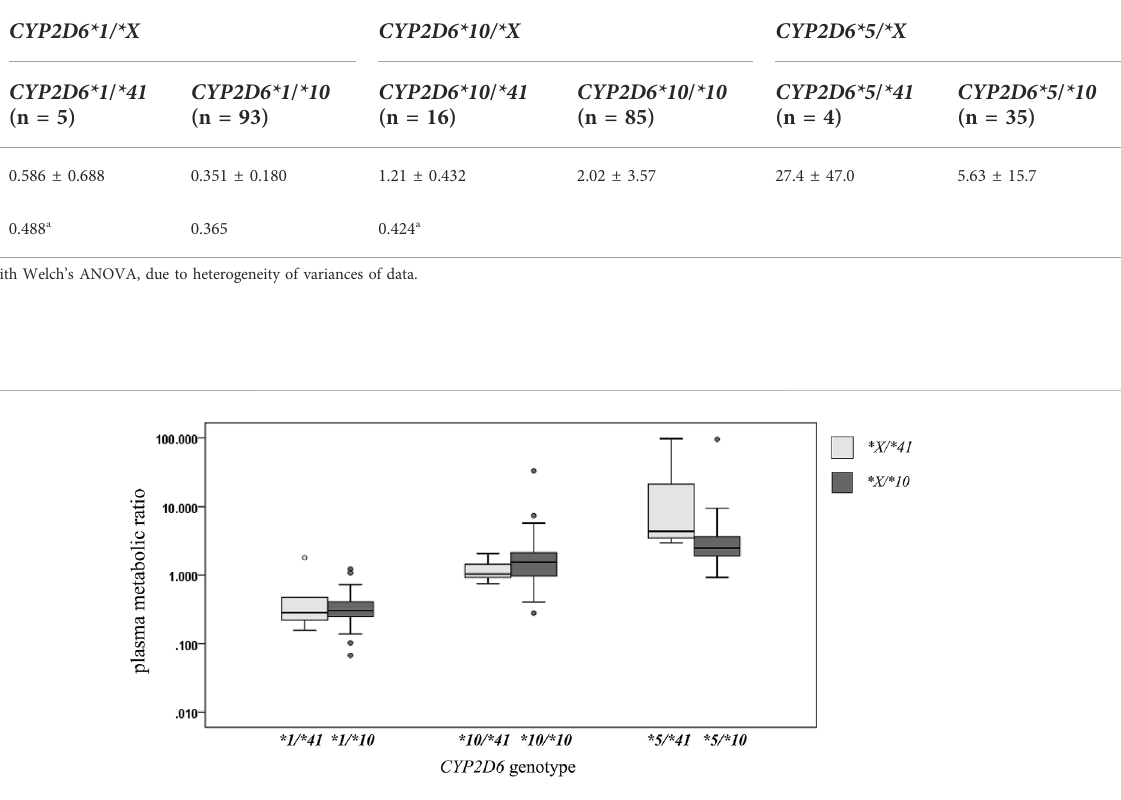
FIGURE 3 The box plot of comparison of plasma MRs for CYP2D6*1/*41 vs. *1/*10 , CYP2D6*10/*41 vs. *10/*10 , and CYP2D6*5/*41 vs. *5/*10 genotypes in the subjects. The legend *X/*41 represents genotype *1/*41 , *10/*41 or *5/*41 . The legend *X/*10 represents genotype *1/*10 , *10/*10 or *5/*10